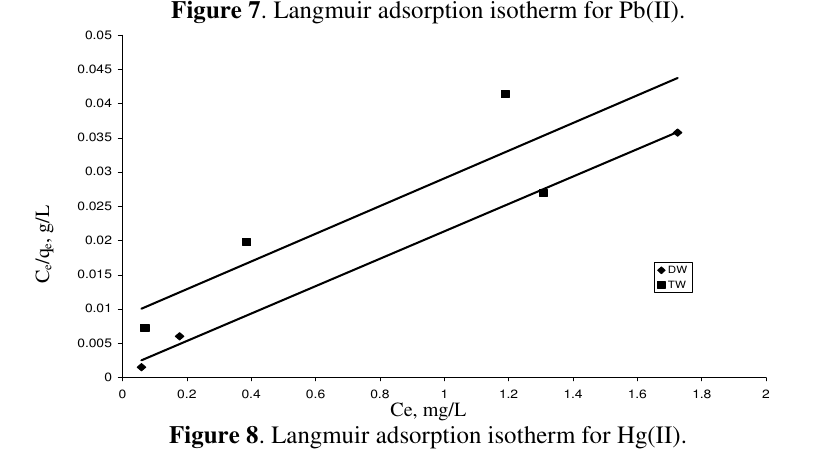
values for Pb(II) and Hg(II). L R values, Distilled water R L